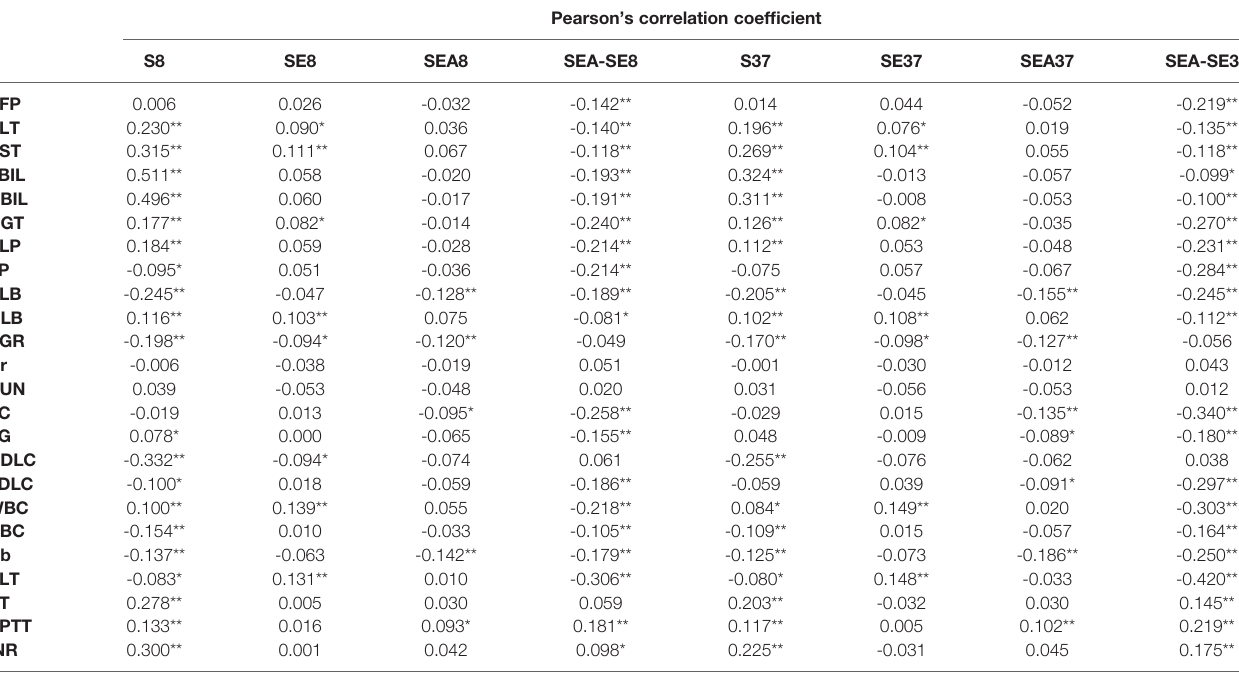
TABLE 3 | Correlations of aptamer-based triple serum fl uorescence intensity indicators with laboratory blood